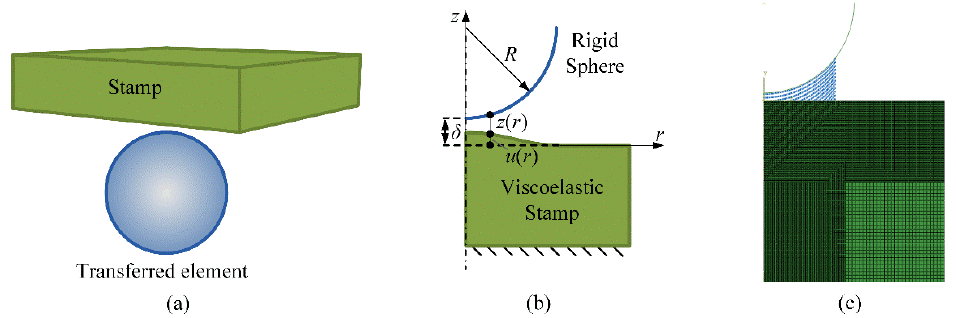
Figure 1. Schematics of the contact model between a viscoelastic stamp and a spherical transferred element. ( a ) three-dimensional model; ( b ) reduced axisymmetric model; ( c ) finite element model.